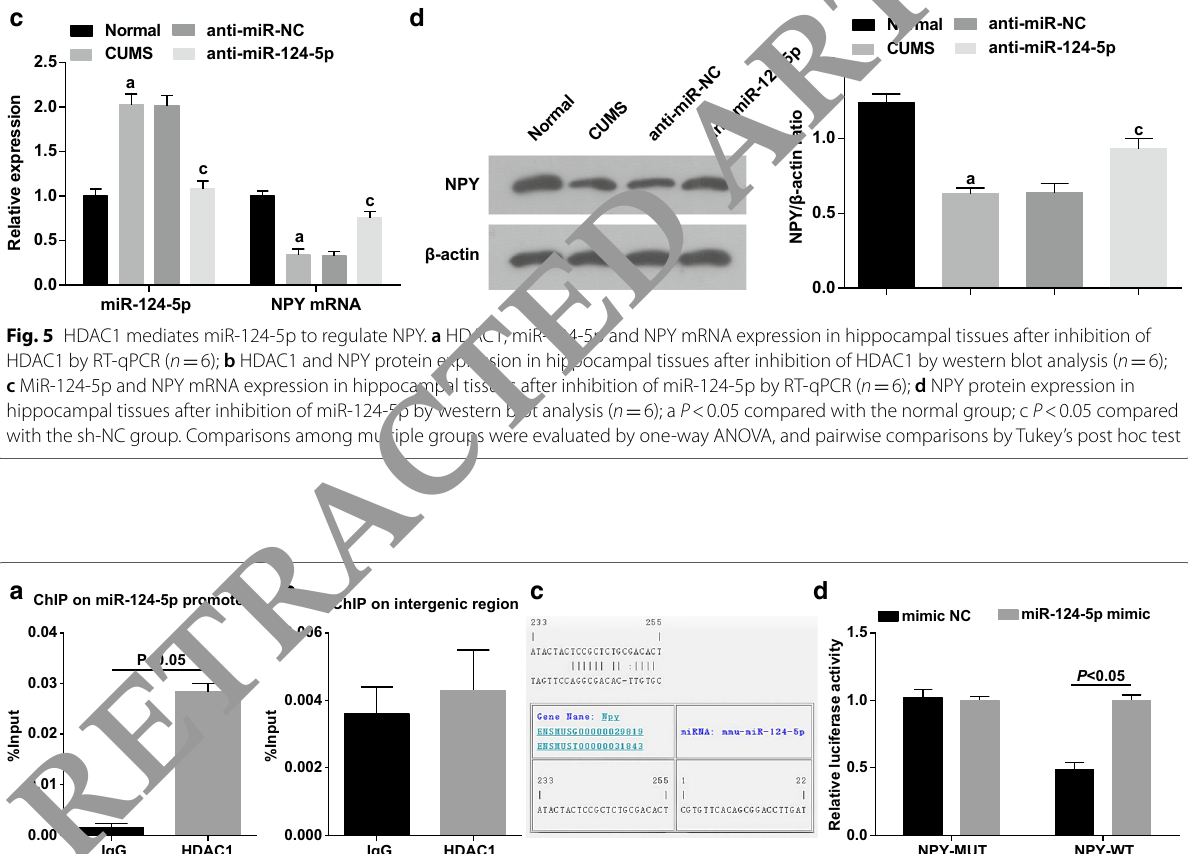
Fig. 6 HDAC1 binds to the promoter of miR-124-5p. a Binding abundance of HDAC1 and miR-124-5p promoter region in HEK293T cells by ChIP assay ( n 3); b Binding abundance of HDAC1 and unrelated intergenic regions in HEK293T cells by ChIP assay ( n = binding site by biological information software website; d Targeting relationship between miR-124-5p and NPY by dual luciferase reporter